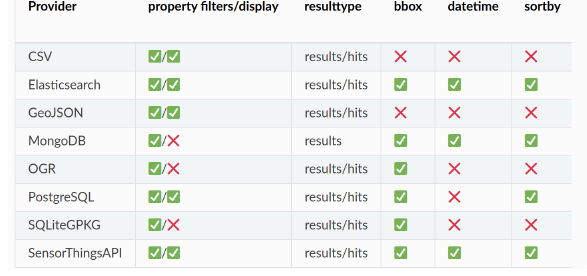
Figure 2. pygeoapi data providers and